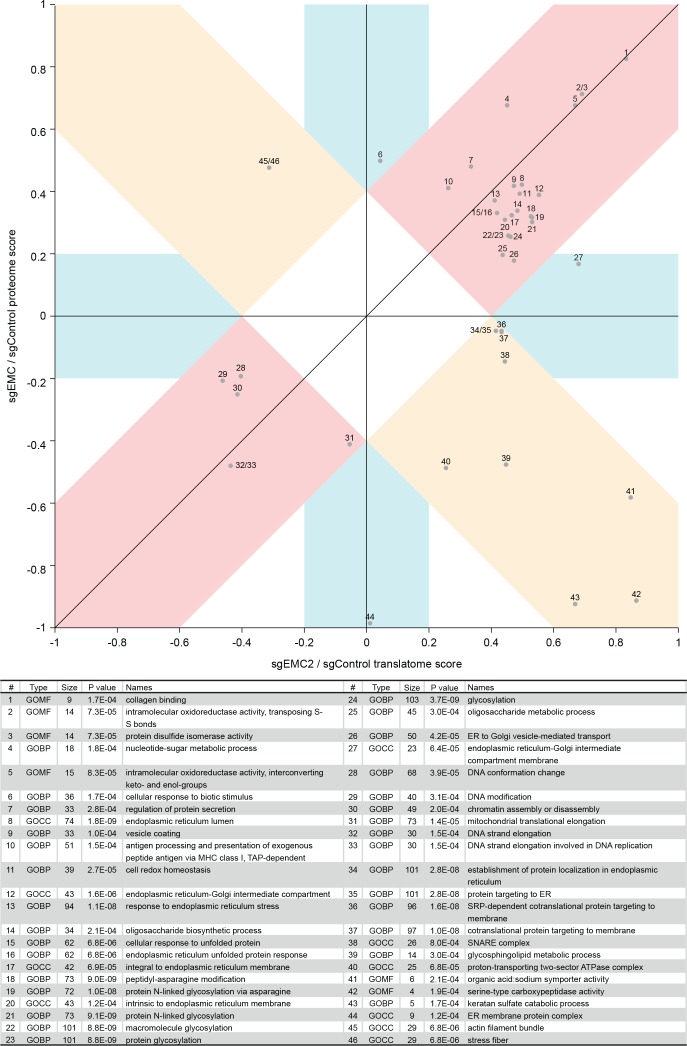
2D annotation enrichment based on the protein ratios and ribosome profiling ratios of EMC knockdown versus control knockdown cells.Each point relates to a GO term whose corresponding protein or RNA expression values are significantly skewed in their distribution compared to the global distribution of the values for all proteins. The position on the plot relates to how the distribution is skewed, for example point one is concordantly upregulated at both the RNA and protein level in EMC2 knockdown cells.